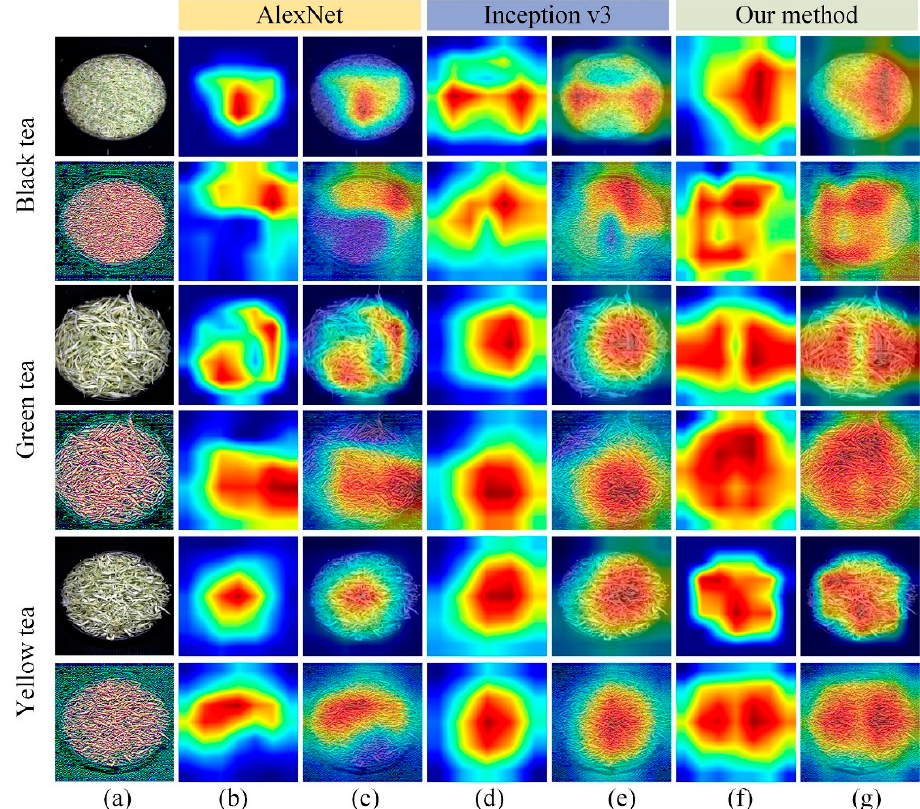
Figure 8. Samples visualization based on Grad-CAM. ( a ) represents the original hyperspectral image and wavelet component LL+LH+HL; ( b , d , f ) represent the activation heatmaps of tea sample recognition based on the AlexNet model, Inception v3 and our proposed method; ( c , e , g ) represent the activated heatmaps superimposed on the original image of tea sample recognition based on the AlexNet model, Inception v3 and our proposed method.